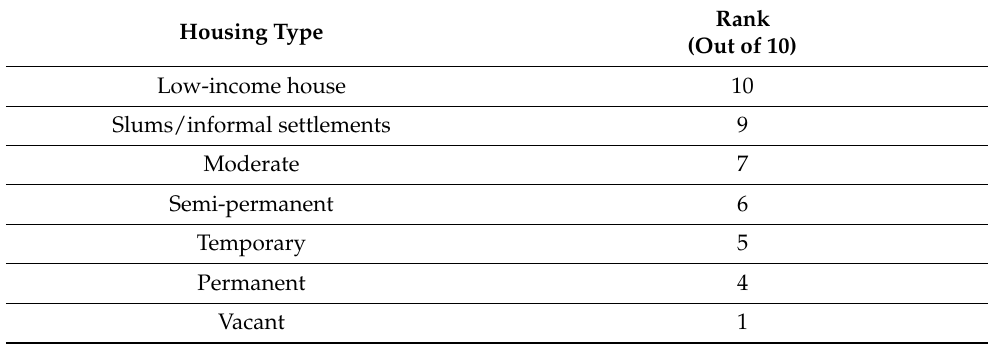
Table 10. Ranking of sub-class parameters—housing type.